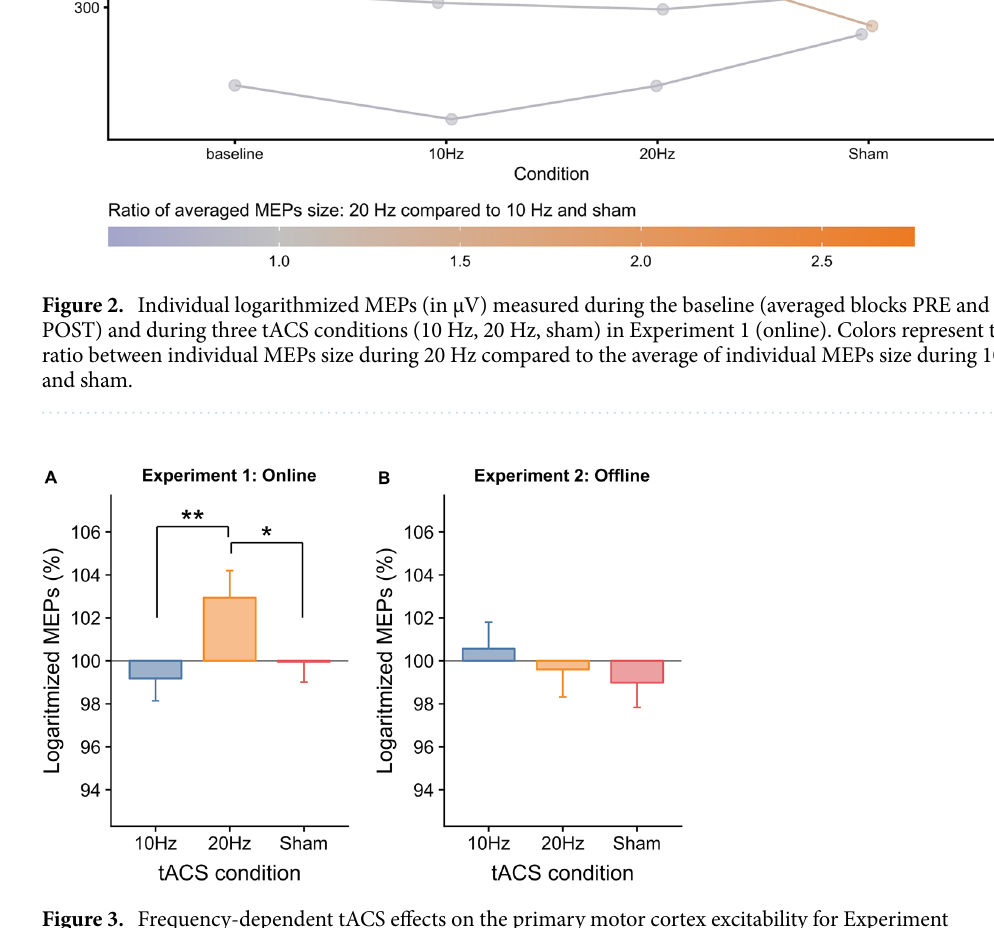
Figure 3. Frequency-dependent tACS effects on the primary motor cortex excitability for Experiment 1 (online) and 2 (offline). ( A ) Relative change in % of logarithmized MEPs compared to the baseline in Experiment 1 for three tACS conditions (10 Hz, 20 Hz, sham). ( B ) Averaged across time relative change in % of logarithmized MEPs compared to the baseline in Experiment 2 (offline) for three tACS conditions (10 Hz, 20 Hz, sham). Error bars indicate sem. * p < 0.05; ** p <